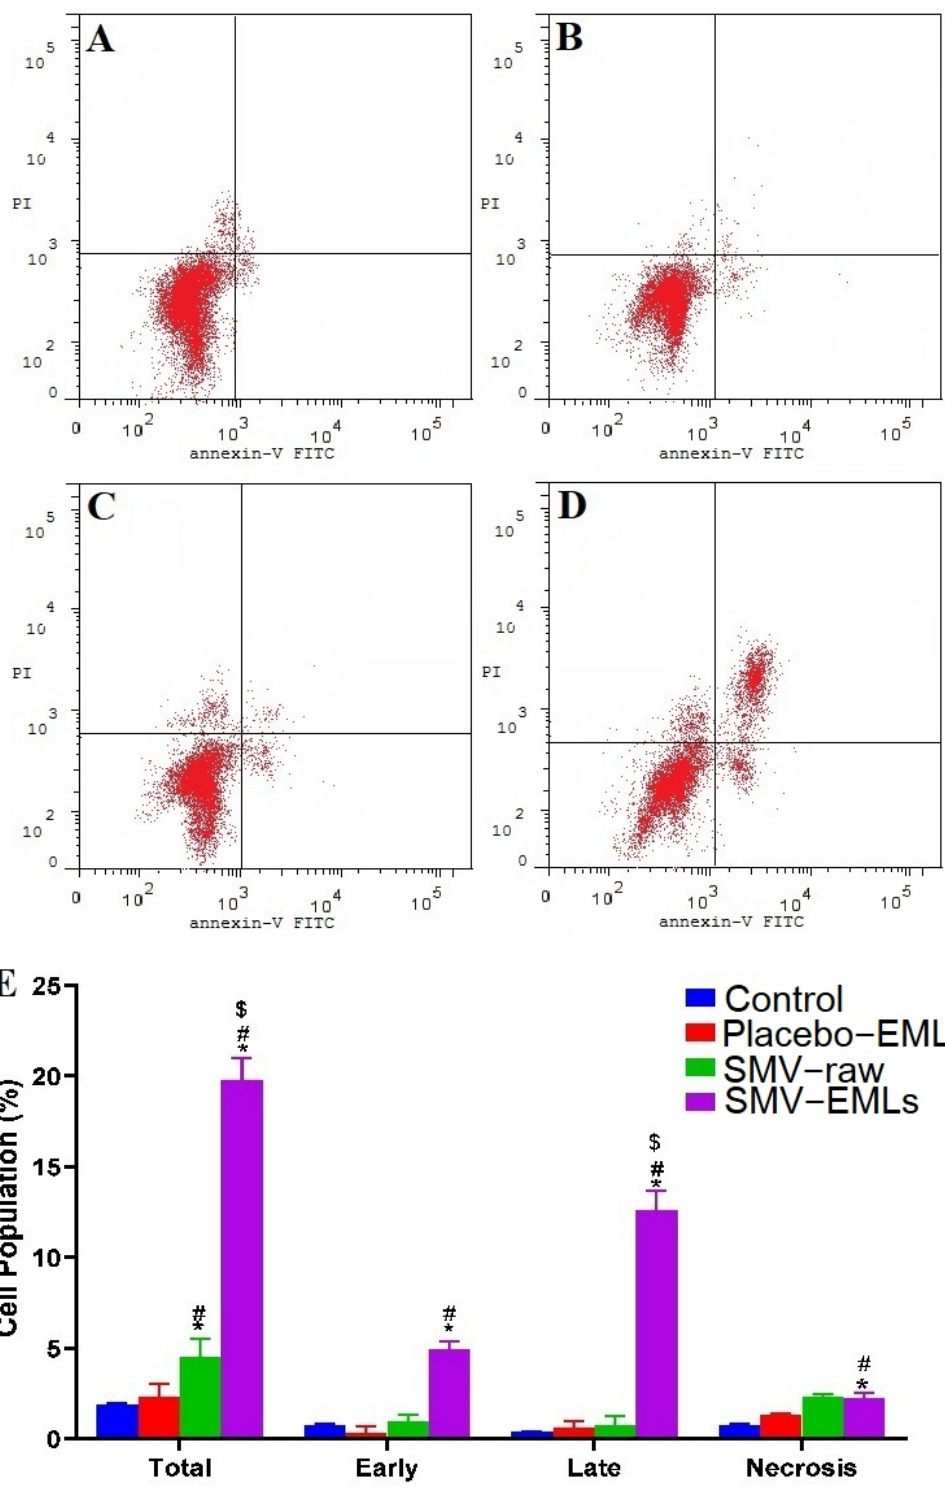
Figure 8. Impact of Placebo-EMLs, SMV-raw, or optimized SMV-EMLs treatments on the annexin-V FITC positive-staining of MCF-7 cells. ( A ) Control, ( B ) Placebo-EMLs, ( C ) SMV-raw, ( D ) SMV-EMLs, and ( E ) graphical presentation of apoptosis + necrosis (total), early and late stages of apoptosis, and necrosis. * Significantly different vs. Control ( p < 0.05); # Significantly different vs. Placebo-EMLs ( p < 0.05); $ Significantly different vs. SMV-raw ( p < 0.05).